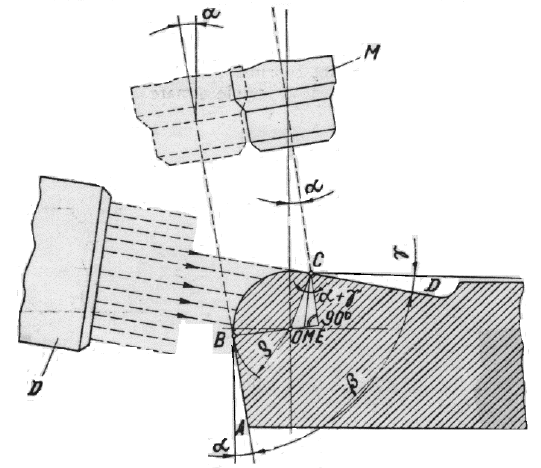
Figure 7. Double microscope Linnik – Schmaltz cutting edge radius measuring, where: α— clearance angle; γ —rake angle; (cid:36) —cutting edge radius; β —sharpening angle; M—objective lens; and D—light angle; γ—rake angle; ρ—cutting edge radius; β— sharpening angle; M — objective lens; and D — light source.